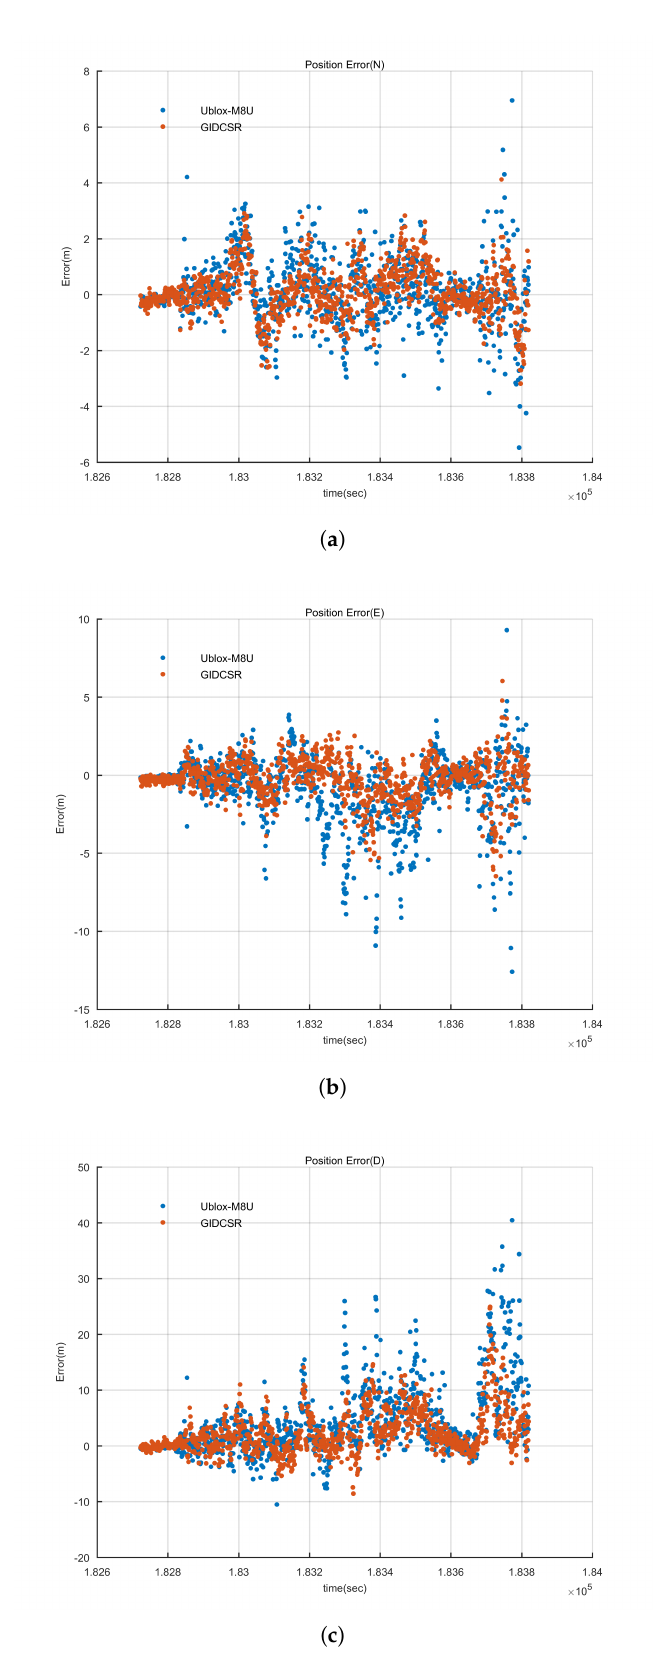
Figure 20. GNSS positioning errors comparison. ( a ) North direction ( b ) East direction ( c )